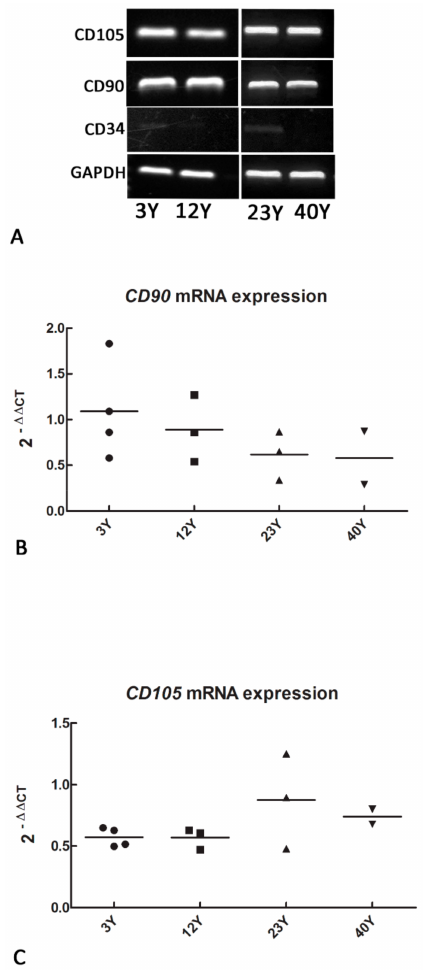
Figure 1. ( A ) RT-PCR analysis showing a positive expression of CD105 and CD90 and a negative expression of CD34 mesenchymal stromal surface markers in synovial fluid mesenchymal stromal cells (SfMSCs) cultured from equine donors of di ff erent ages: 3Y (3 years old), 12Y (12 years old), 23Y (23 years old), and 40Y (40 years old). Representative images of three independent experiments; ( B ) real-time PCR data showing the quantitative expression of CD90 mRNA. The value corresponding to each single donor and the mean level inside each group (black line) was reported. ( C ) Real-time PCR data showing the quantitative expression of CD105 mRNA. The value corresponding to each single donor and the mean level inside each group (black line) was reported. The values are represented as fold increases related to a reference control consisting of a pool of four di ff erent healthy equine subjects, each 3 years old. No statistical di ff erences were observed between